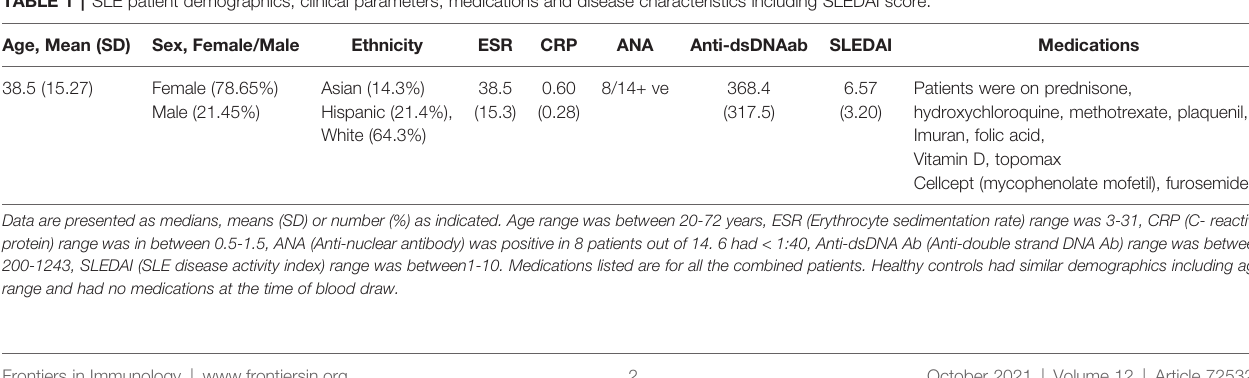
TABLE 1 | SLE patient demographics, clinical parameters, medications and disease characteristics including SLEDAI score. Age, Mean (SD) Sex, Female/Male